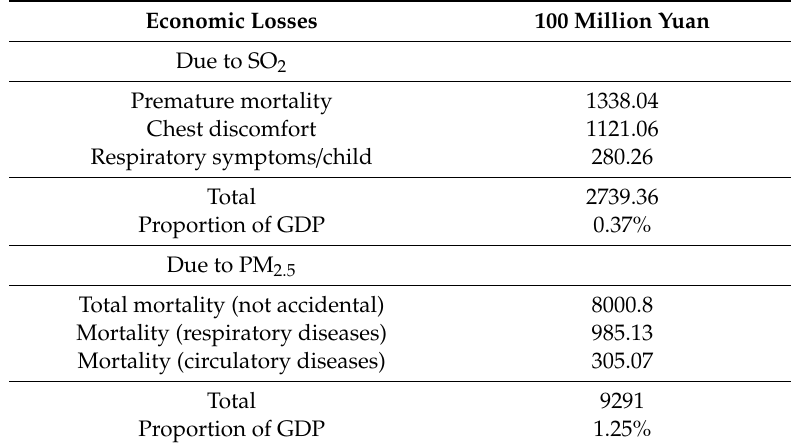
Table 6. Economic losses of SO 2 and PM 2.5 emissions in energy intensive sectors